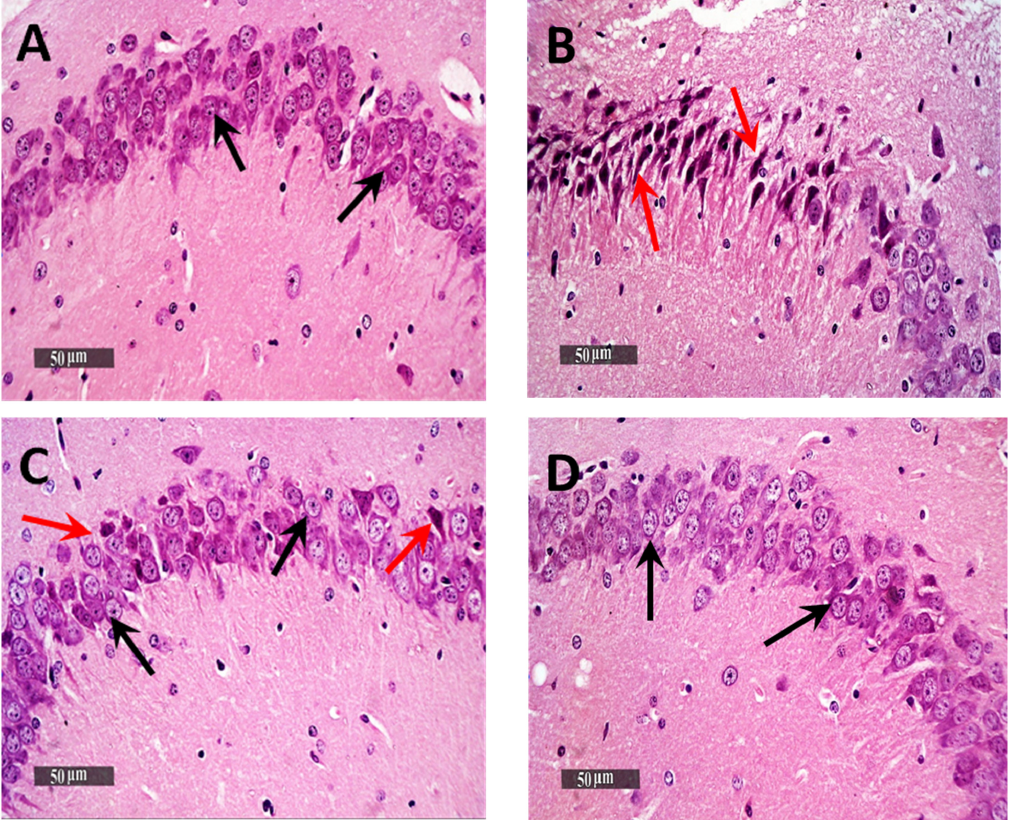
Figure 5. Neuroprotective histological effect of different treatments on CA3/hippocampal sub-regions of AD model. ( A ) normal group, ( B ) negative control group (received 0.9% saline), ( C ) positive control group (received resveratrol suspension) and ( D ) test group (received resveratrol bilosomes). H&E stain, 400×.